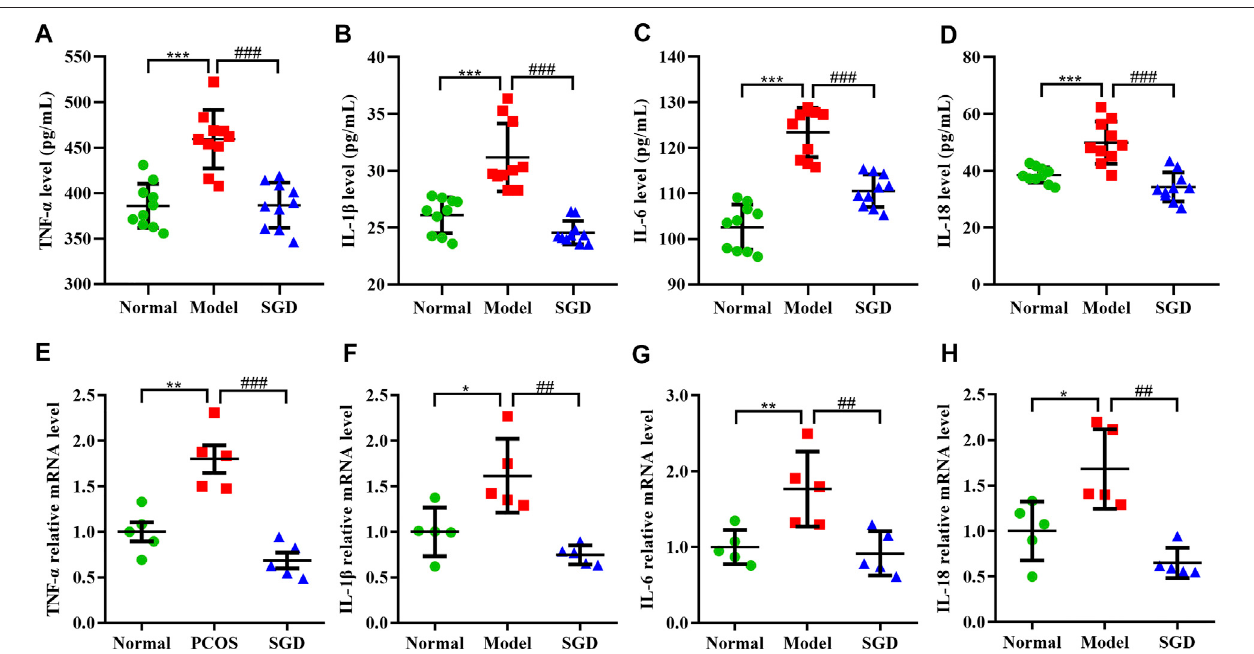
FIGURE2| SGD alleviatedthechroniclow-gradein fl ammation inPCOS rats. (A – D) Serum levels ofin fl ammatorycytokines including TNF- α ,IL-1 β ,IL-6, and IL-18 were determined by using ELISA kits ( n (cid:1) 10). (E – H) The mRNA levels of in fl ammatory cytokines including TNF- α , IL-1 β , IL-6, and IL-18 in rats ovarian tissues were quantitated by real-time PCR ( n (cid:1) 5). Data were presented as mean ± SEM. * p < 0.05, ** p < 0.01, and *** p < 0.001 vs. normal group, ## p < 0.01 and ### p < 0.001 vs. PCOS model group.